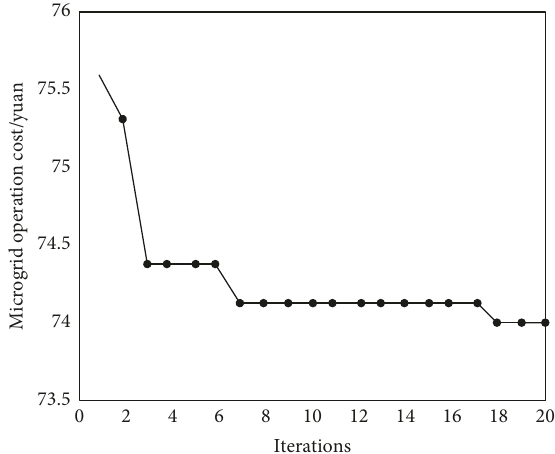
Figure 8: Optimization curve of the island microgrid operating cost in the 39th